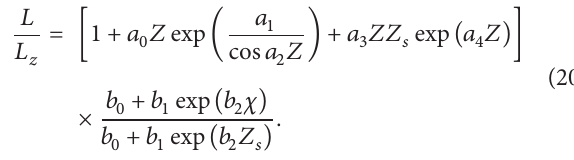
Figure 9: Plots of 𝑓(𝜒)/𝑓(𝜒 index ( 𝑛 ). 𝜒 is indicatrix angle.